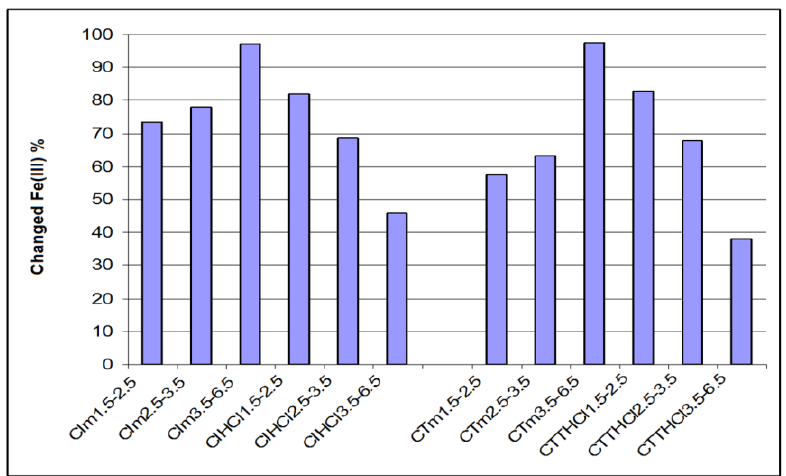
Figure 3. Iron percent changed through chemo-sorption in industrial and traditional ceramics treated with HCl and untreated.